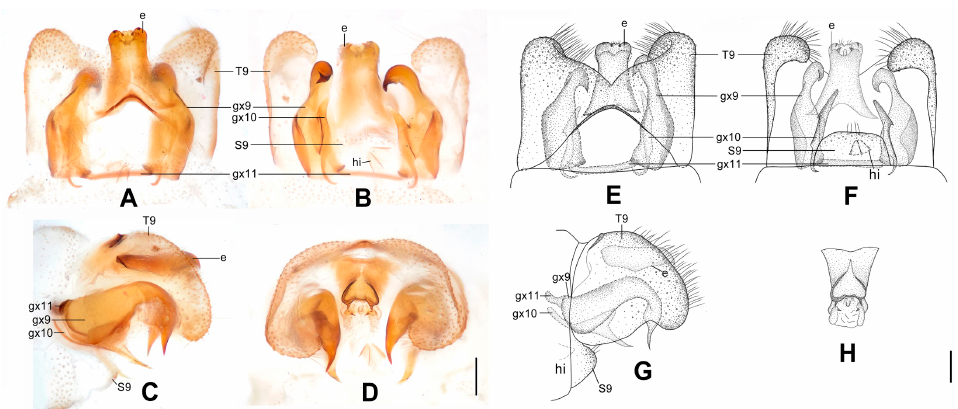
Figure 12. Dilar striatus sp. nov. ( A – D ) male holotype, genitalia, photographs: ( A ) dorsal view; ( B ) ventral view; ( C ) lateral view; ( D ) caudal view. ( E – H ) male holotype, genitalia, line drawings: ( E ) dorsal view; ( F ) ventral view; ( G ) lateral view; ( H ) ectoproct, caudal view. e: ectoproct; gx9: gonocoxite 9; gx10: gonocoxite 10; gx11: fused gonocoxites 11; hi: hypandrium internum; S9: sternum 9; T9: tergum 9. Scale bars: 0.2 mm.